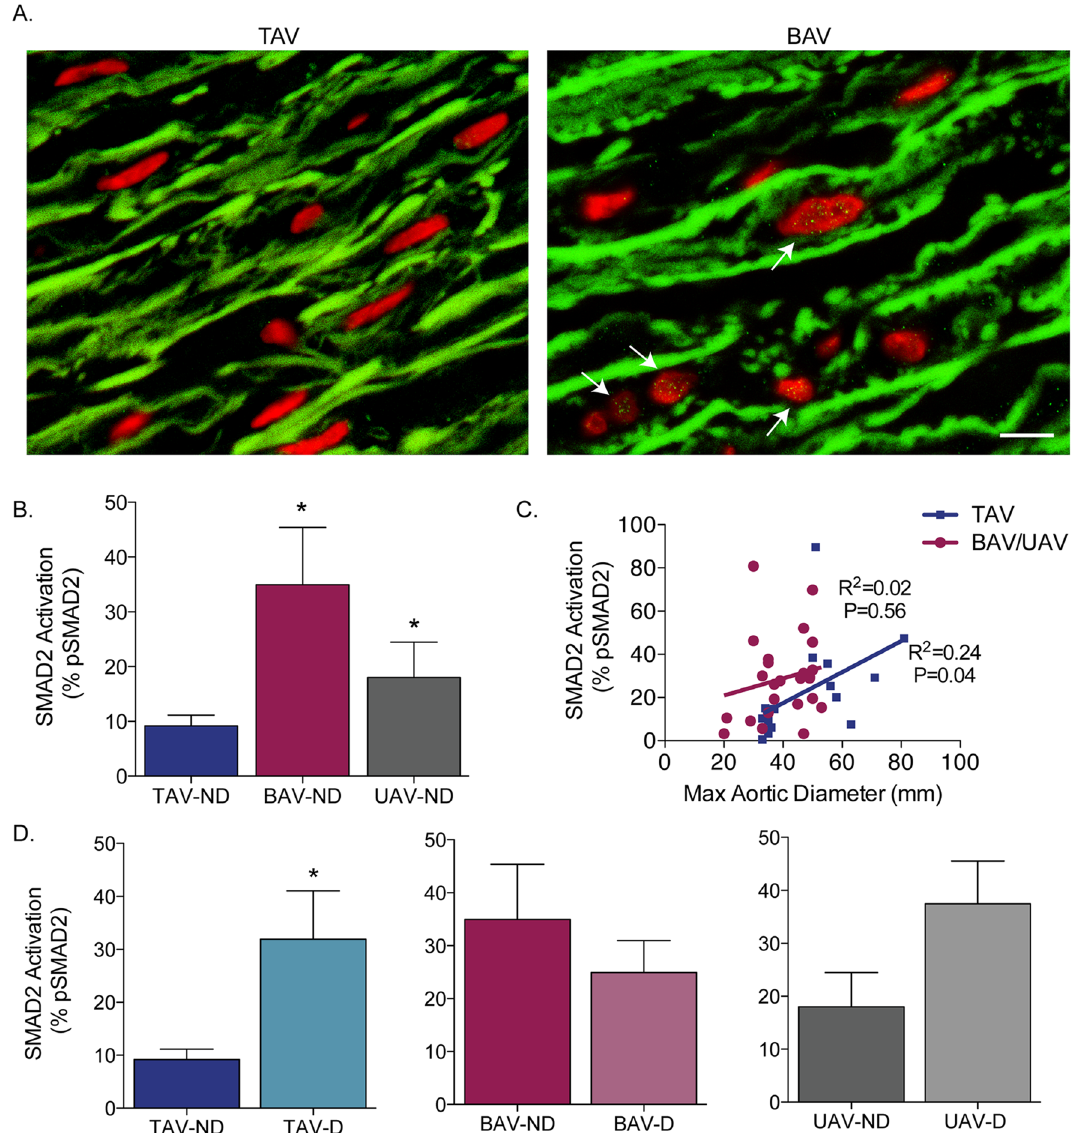
Figure 2. SMAD2 phosphorylation is increased in non-dilated bicuspid (BAV) and unicuspid (UAV) aortic valve aortas, and increases with dilatation in tricuspid aortic valve (TAV) aortas. ( A ) Fluorescent micrographs of ascending aortic cross-sections immunolabeled for phosphorylated SMAD2 (green points inside nuclei, indicated by white arrows) and counter-stained with DAPI (red). ( B ) Graph depicting the percentage of phosphorylated SMAD2 (pSMAD2)-positive smooth muscle cells in non-dilated (ND) aortas from individuals with a TAV, BAV or UAV. ( C ) Graph depicting the relationship between pSMAD2 and maximal ascending aortic diameter in TAV (blue) and BAV/UAV (pink) aortas. ( D ) Graphs depicting the percentage of pSMAD2-positive SMCs in ND and D aortas from individuals with a TAV, BAV or UAV. *P < 0.05. Scalebar = 10